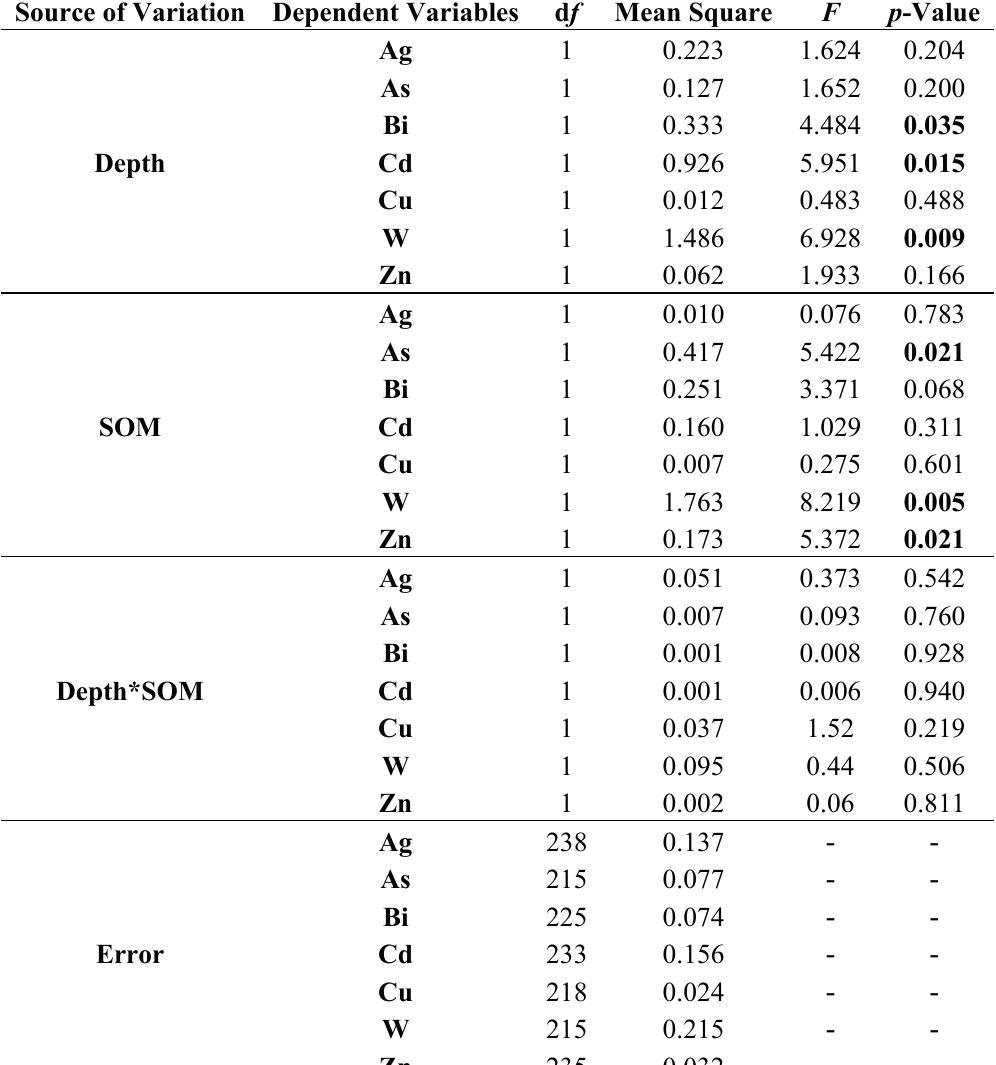
Table 6. Two-way ANOVA results between the dependent (PTEs) and independent (depth, SOM) variables. PTEs were subjected to log-normal transformation (As, As, Cd, Cu, W and Zn with α = 0.050; Bi with α =